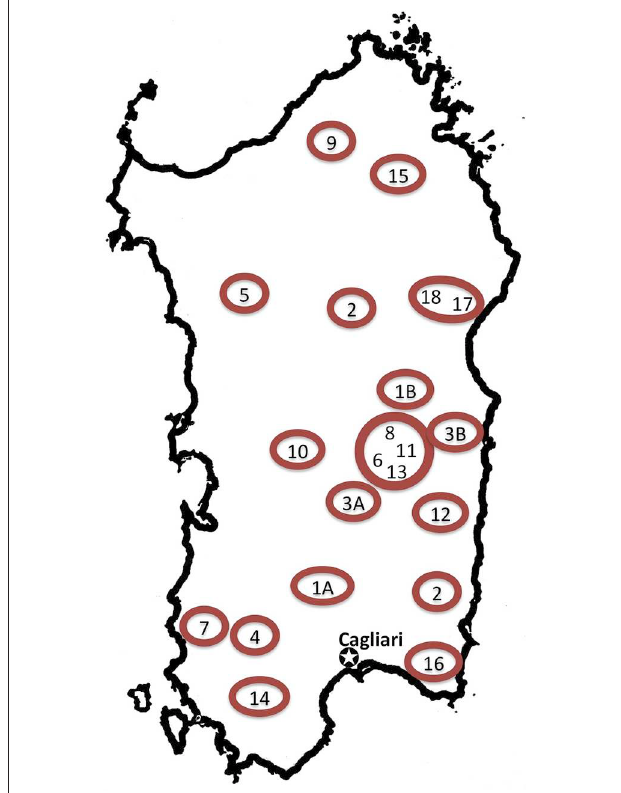
FIGURE 2 | Map of Sardinia indicating considered field studies addressing popular medicinal plant use. 1A, Campidano; Cagliari (Bruni et al., 1997 ); 1B, Urzulei, Ogliastra (Bruni et al., 1997); 2, Sarrabus, Cagliari (Palmese et al., 2001); 3A, Escolca, Cagliari (Loi et al., 2005); 3B, Lotzorai, Ogliastra (Loi et al., 2005); 4, Marganai, Carbonia-Iglesias (Ballero and Fresu, 1991); 5, Monteleone, Sassari (Ballero and Poli, 1998); 6, Seui,